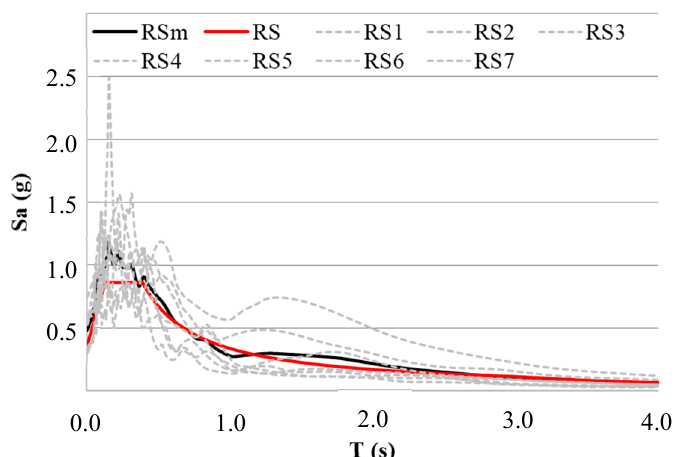
Figure 8. Individual response spectra ζ = 5%, “component” of the ground motion records (transverse direction of bridge models) for the seven unscaled ground motions (RS1, …, RS7) and their median response spectrum (RSm), used for the pushover analyses, with the RS being the code elastic spectrum used for the bridges (RB and IB) design.